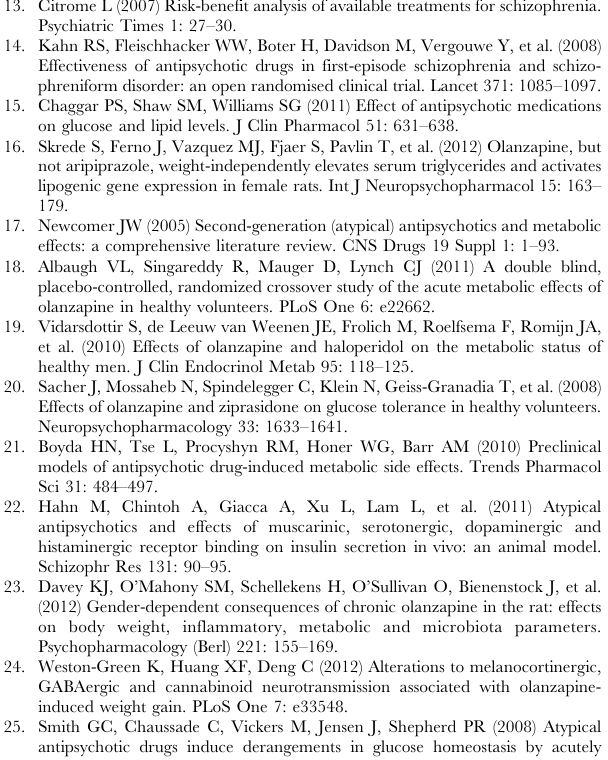
Figure 4. Acute effects of the atypical antipsychotic drug olanzapine on glucose levels in adult female rats. ( A ) Animals (n=8–10 per group) received a single injection of vehicle or olanzapine (0.1, 0.5, 1.5, 5.0, 15.0 mg/kg, s.c). Glucose levels were recorded prior to drug treatment in overnight-fasted rats at Time 0, and then 30 minutes following drug administration ( x-axis ). Immediately following this glucose measurement, all rats were subjected to a glucose tolerance test by receiving an intraperitoneal challenge injection of 1 mg/ml/kg of glucose, and blood glucose levels were measured every 15 minutes for the next two hours. Total cumulative glucose levels for each treatment group are summed as the ‘‘area under the curve’’ during the glucose tolerance test by graph insets ( top right ). Values represent group means 6 SEM. * indicates different from vehicle- treated animals, p , 0.05; ** indicates different from vehicle-treated animals, p , 0.01 ( B ). A separate cohort of animals (n=6–8 per group) were fasted over-night and subjected to the hyperinsulinemic-euglycemic clamp. After animals reached euglycemia (three consecutive blood glucose readings of 6.0 6 0.4 mmol/L), rats were treated with vehicle, low (1.5 mg/kg) or high dose (15.0 mg/kg) olanzapine (arrow at t=0 min). Glucose levels were recorded every 10 minutes and the glucose infusion rate was adjusted as needed. Glucose infusion rates for each treatment group are presented as change in glucose infusion rate from euglycemia. Values represent group means 6 SEM. * indicates different from vehicle and low-dose olanzapine- treated animals, p ,